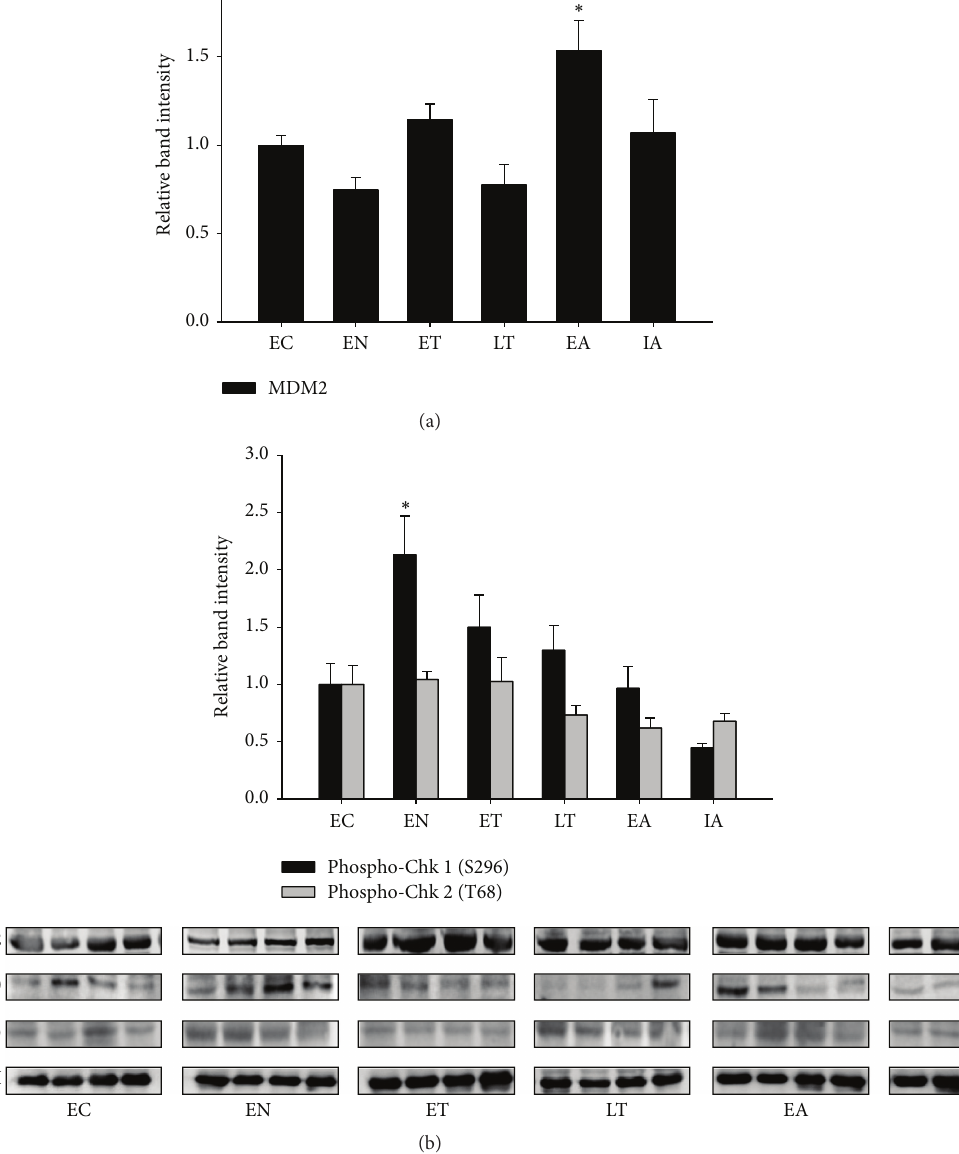
Figure2:Expressionofp53upstreamregulatorsinthegroundsquirrelskeletalmuscleoversixstagesofthehibernationcycle.Relativeprotein expressions and Western blots are shown for (a) MDM2 protein, and (b) phosphorylated checkpoint kinase 1 (S296) and checkpoint kinase 2 (T68). Data show means ± SEM, 𝑁 = 4 -5 independent trials on tissues from different animals. ∗ denotes significant statistical difference from EC values, 𝑝 < 0.05